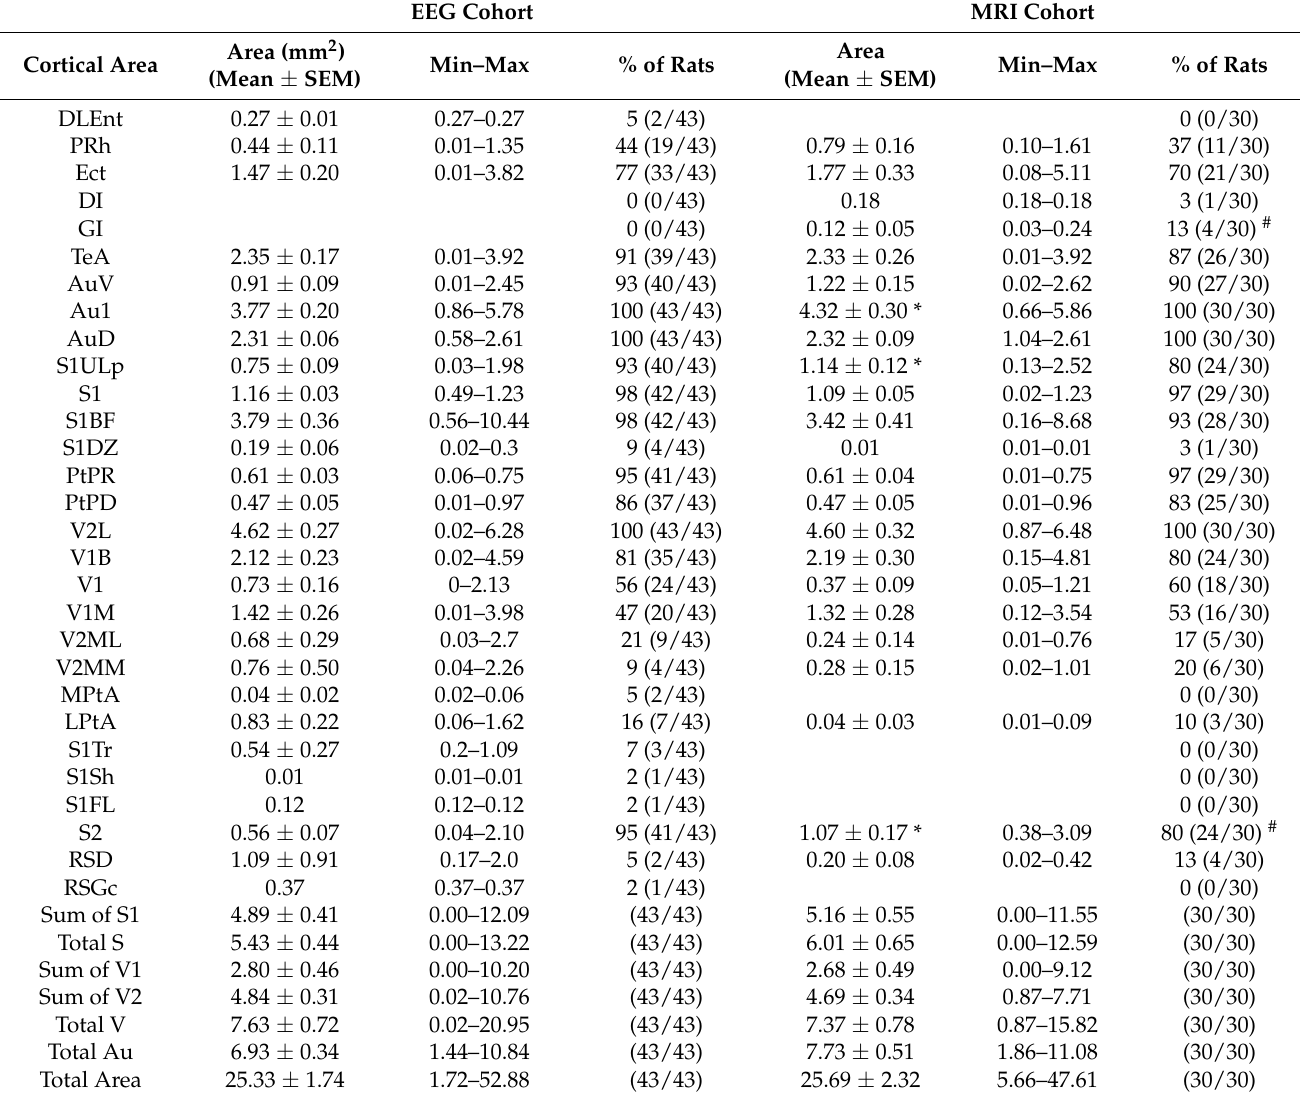
Table 3. Cytoarchitectonic distribution of the TBI-induced cortical lesion in the EEG and MRI